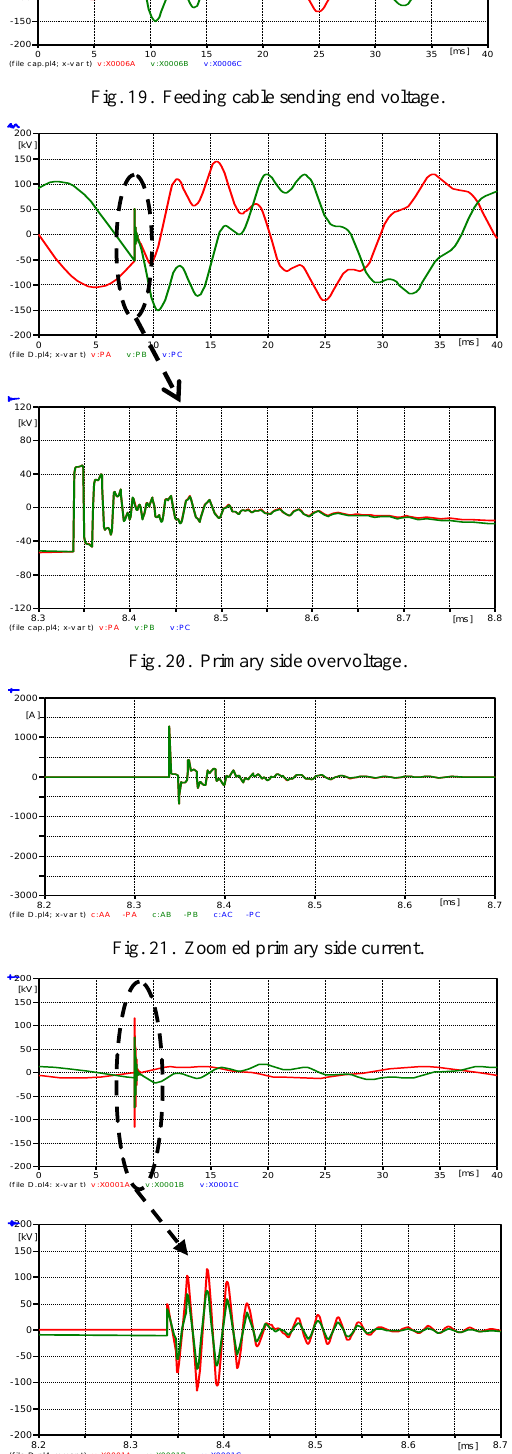
Fig. 22. Secondary side overvoltage.